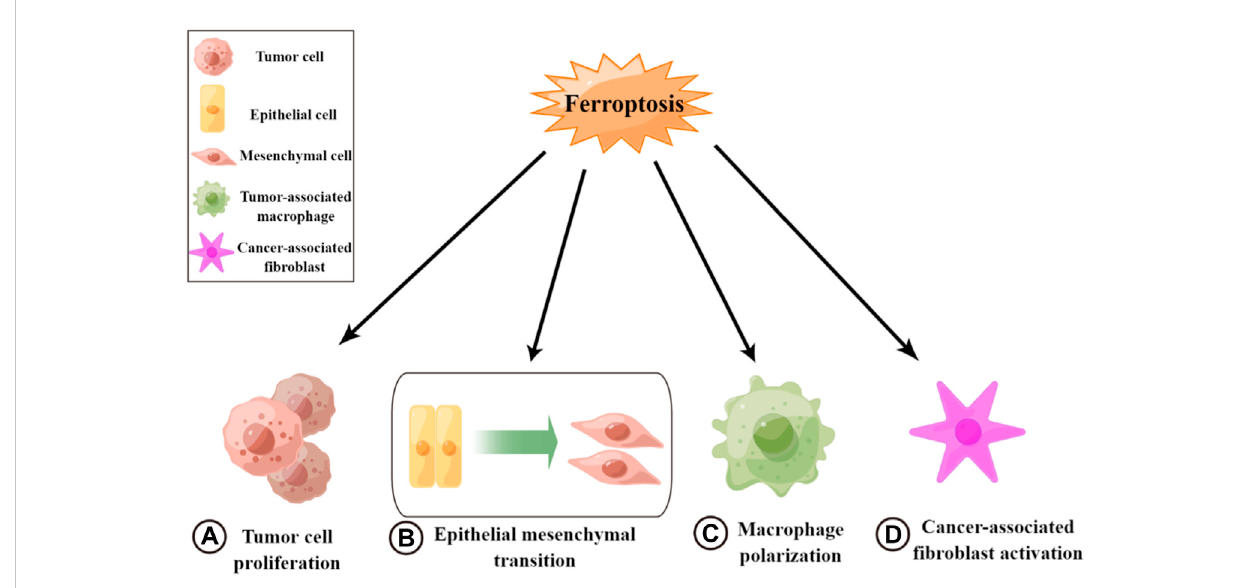
FIGURE 2 Roles of ferroptosis in tumor metastasis. (A) Inhibiting tumor cell growth and cell proliferation. (B) Inhibiting epithelial – mesenchymal transition. (C) Promoting macrophage polarization toward M1. (D) Inactivating cancer-associated fi